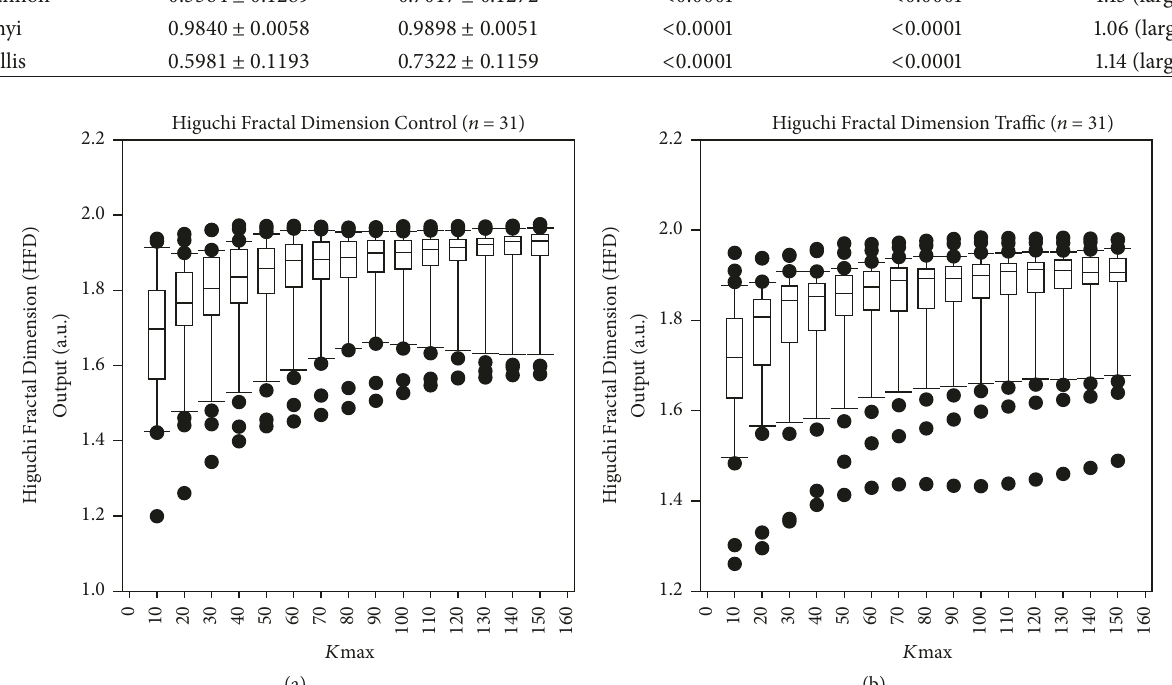
Figure 7: Box-and-whiskers plot for Higuchi fractal dimension of RR intervals of the control subjects (a) and the traffic noise exposure subjects (b), calculated multiple times from 10 to 150 in equidistant units for different levels of 𝐾 max .